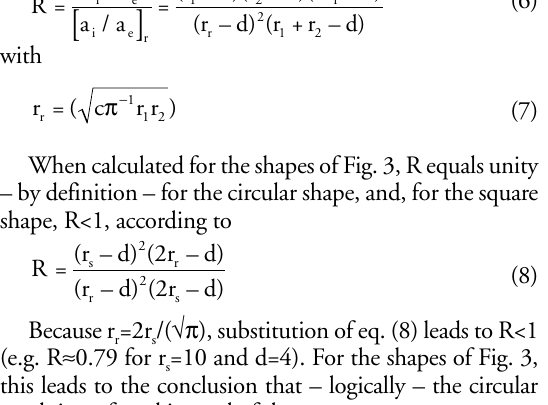
and disturbance depth d; B: square shape c and disturbance depth d. Interior habitats s /a for both shapes A and i e